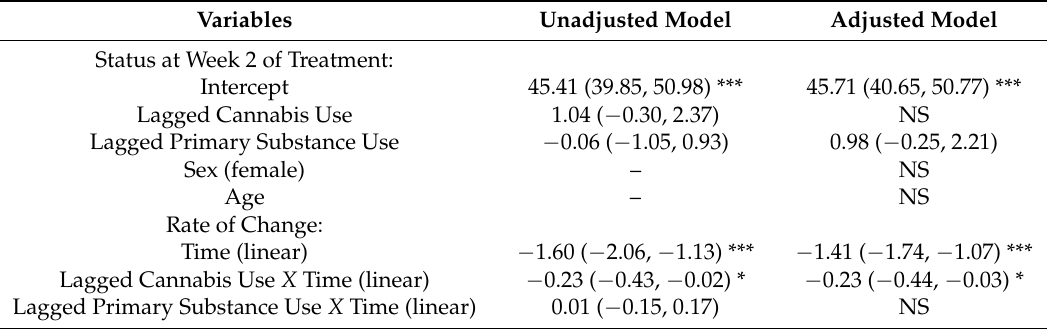
Table 5. Exponentiated regression coefficients for models examining the impact of lagged weekly cannabis use and primary substance use on PTSD symptom severity.